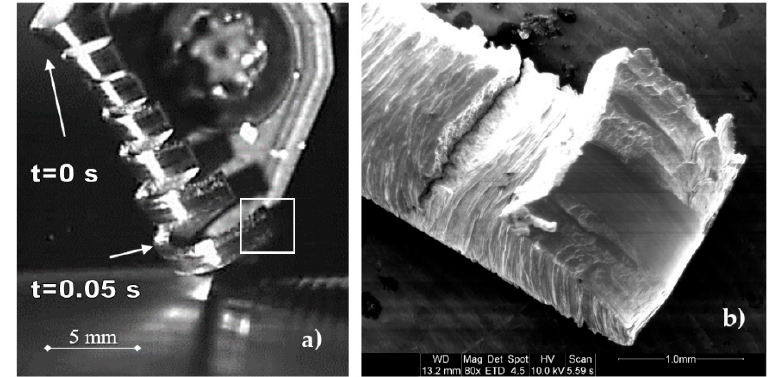
Figure 3. ( a ) High speed filming frame, where the chip formation in the beginning of the machining can be observed. ( b ) SEM image from the chip surface.